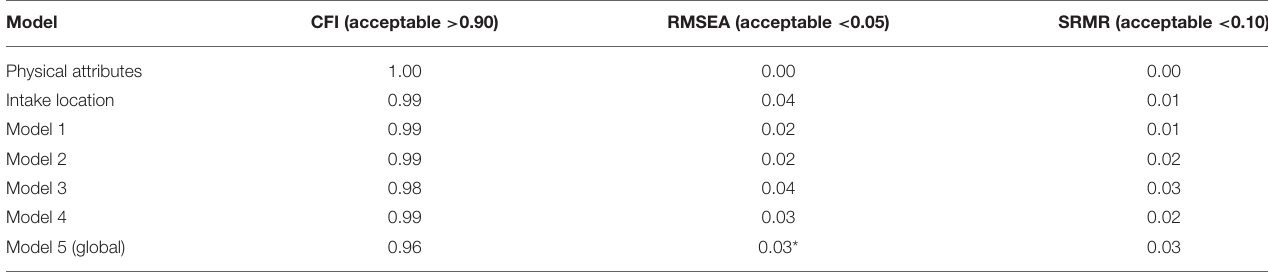
TABLE 2 | Summary of model fit criteria for latent variables (cat characteristics and intake location) and structural equation